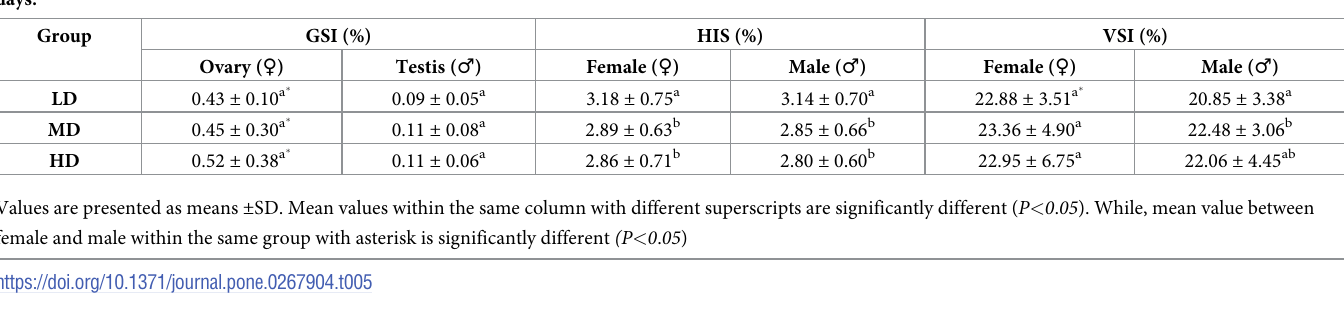
Table 5. Gonadosomatic index (GSI), Hepatosomatic index (HSI) and Viscerosomatic index (VSI), of yellow perch reared at different stocking densities for 180 days. Group